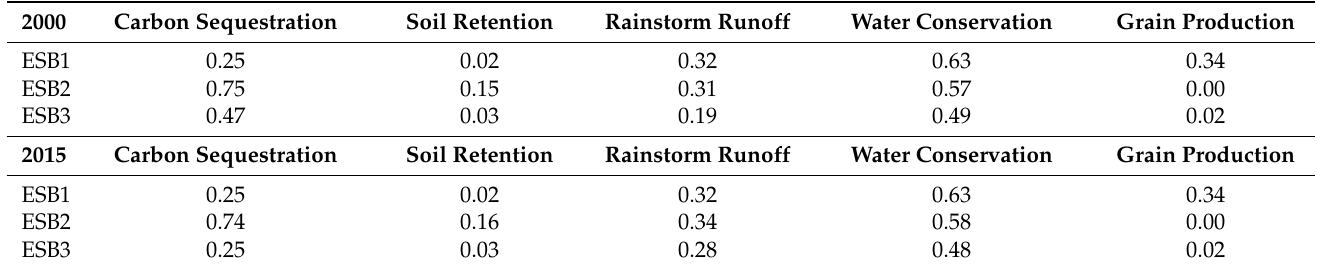
Table 3. Distinct ecosystem service bundles in the Greater Bay Area in 2000 and